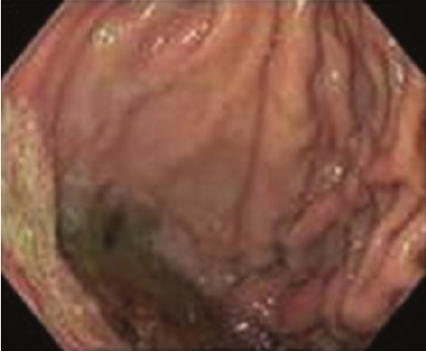
Figure 6: Follow-up EGD demonstrated resolution of varices.